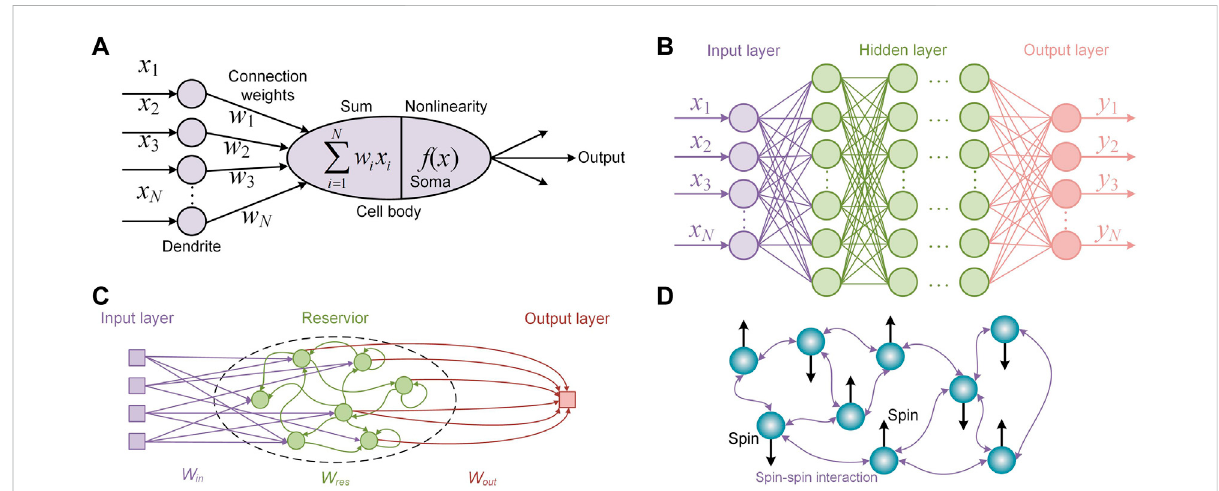
FIGURE 1 (A) Schematicofabiologicalneuron. (B) Themodeloffullyconnectedneuralnetwork. (C) SchematicofastandardRC. (D) SchematicofanIsing machine